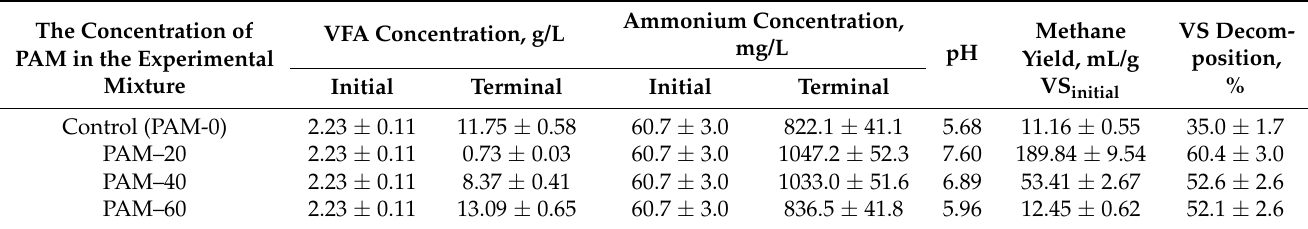
Table 3. Characteristics of the process of anaerobic digestion in the non-mixing